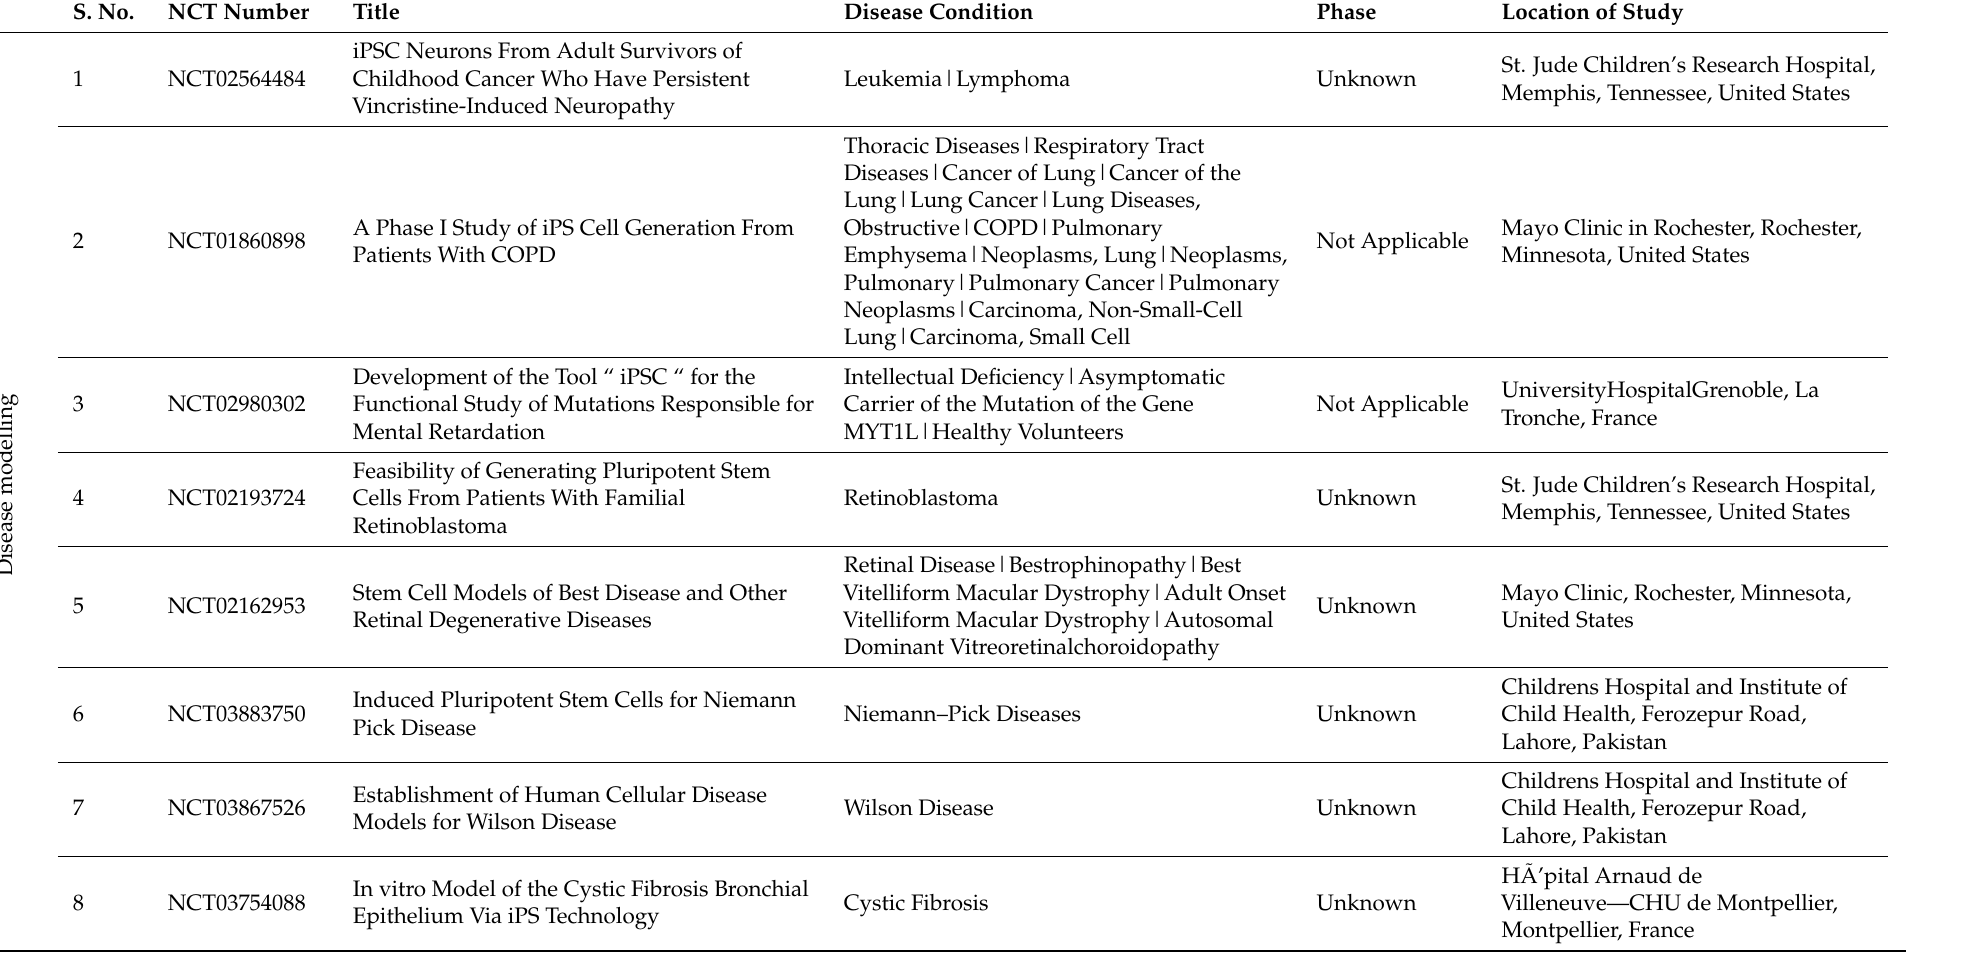
Table 5. Examples of iPSCs-based studies in clinical trials (Row 1 to 20—Disease modelling; Row 21 to 23—Drug screening; Row 24 to 31—Therapy based studies). More details related to the experimental design and expected outcomes of each of the listed study can be accessed from https://www.clinicaltrials.gov/ (accessed on 25 July 2021) using the associated NCT